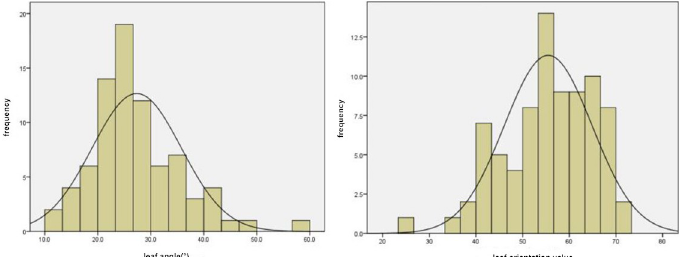
Fig 1. Distribution of leaf angle and leaf orientation value phenotypes in the GWAS population.